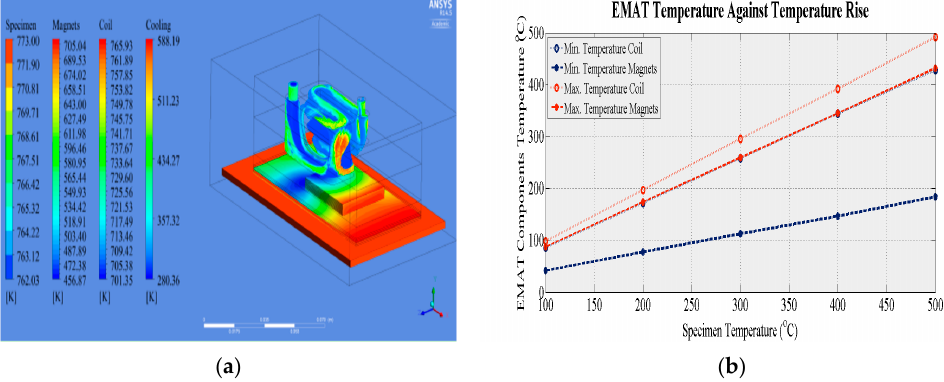
Figure 6. Water cooled EMAT ( a ) temperature gradient of EMAT components at 500 °C; ( b ) temperature of EMAT components against temperature rise. The temperature range of the magnets, coil and the cooling medium are depicted in figure a.